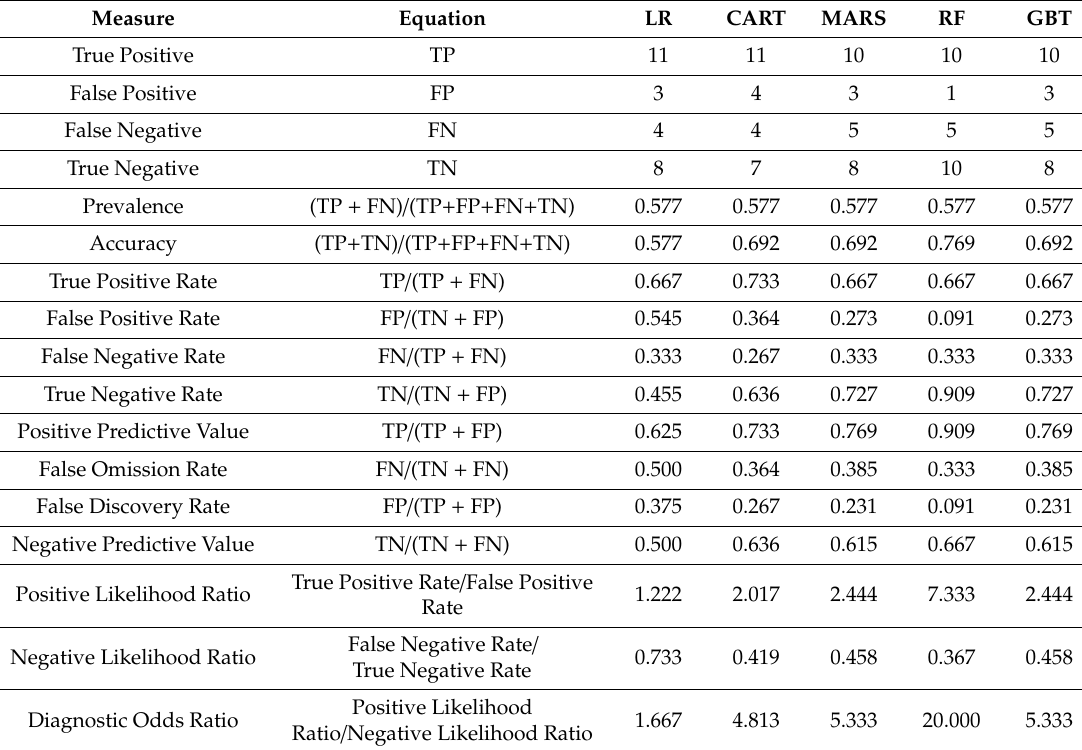
Table 5. Performance Measures of Tree-Based Models for Testing